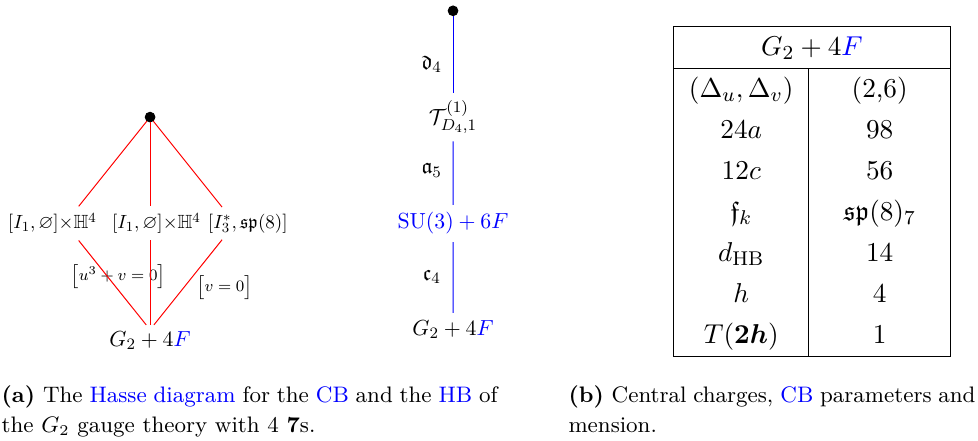
Figure 38. Information about the G 2 N = 2 theory with 4 hypermultiplets in the 7 .